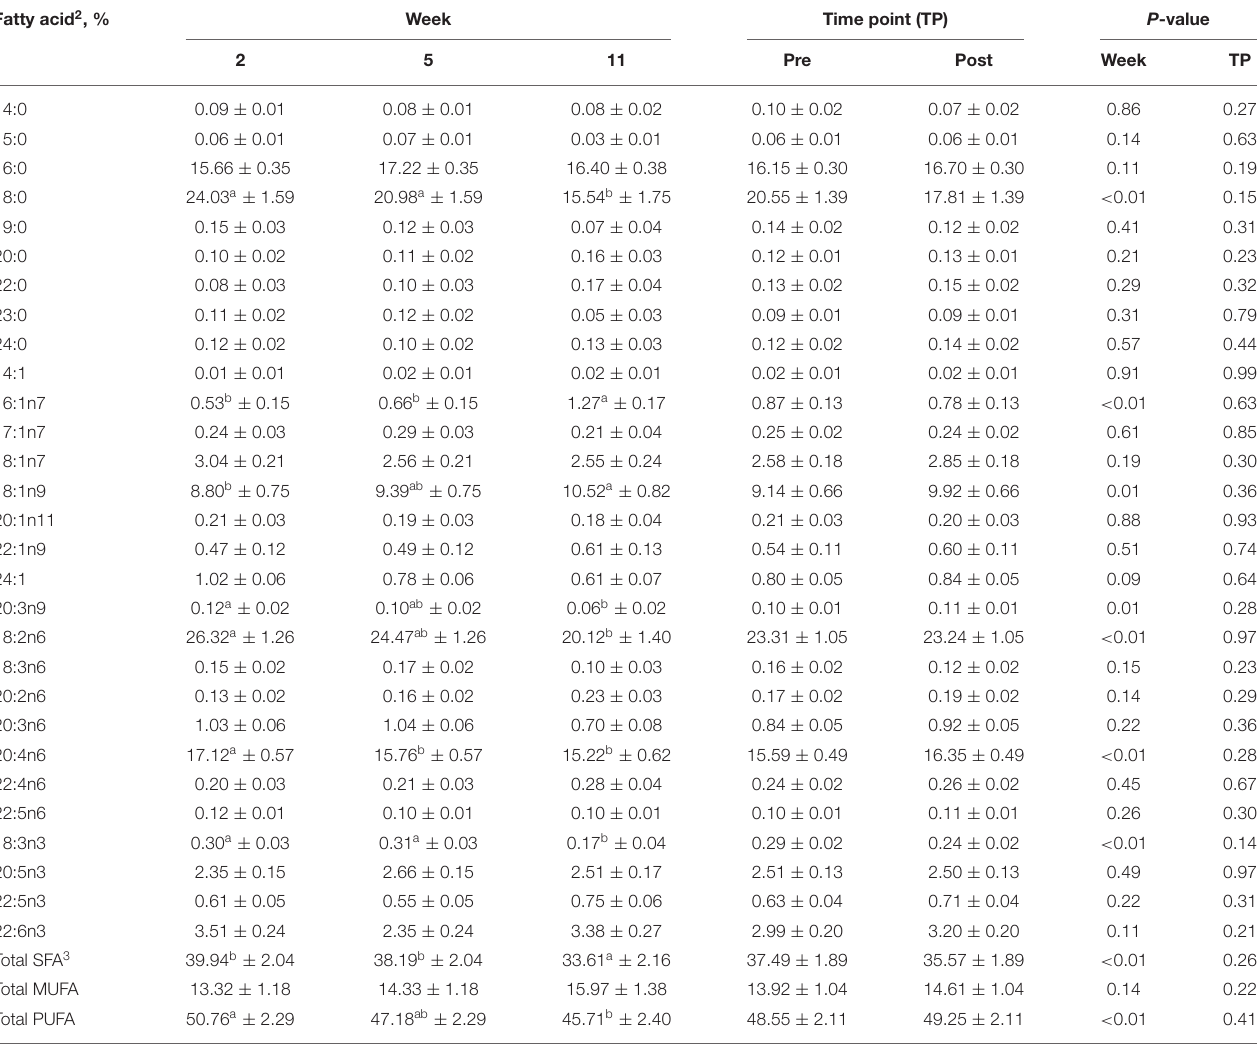
TABLE 5 | Mean fatty acid composition ( ± SE 1 ) and percent contribution of saturated fatty acids (SFA), monounsaturated fatty acids (MUFA), and polyunsaturated fatty acids (PUFA) for the phospholipid (PL) fraction identified in serum of all dogs at weeks 2, 5, and 11 (pooled across pre- and post-exercise sampling time points) and at the pre- and post-exercise sampling time points (pooled across weeks 2, 5, and